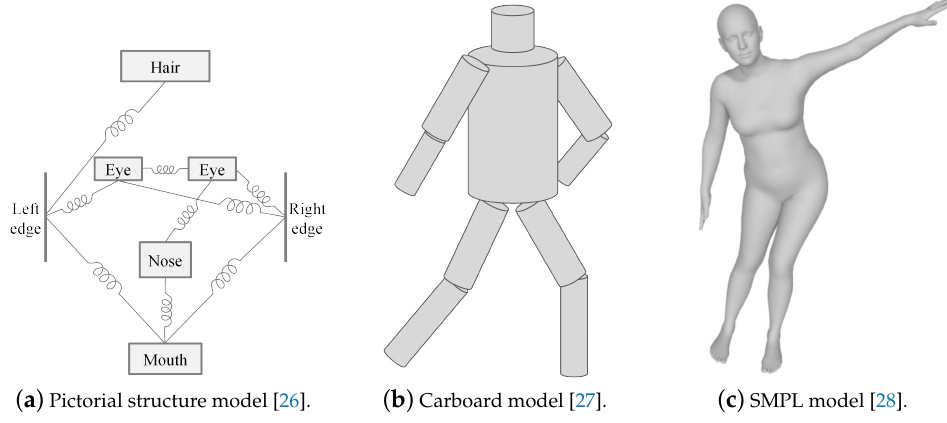
Figure 2. Three types of human body models